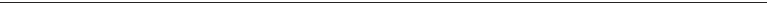
FIGURE1 alkaline cytosolic pH at the root hair tip compared to the base reflects measurements by Bai et al. (2014). (C) Graphical illustration of proton fluxes and oscillatory pH changes at the tip during root hair growth. Light purple arrows indicate net proton fluxes. The pH values are based on the analysis of Monshausen et al. (2007). (D) Growth rate, intracellular Ca 2 + , extracellular pH, and ROS oscillations on a time scale. The figure is adapted from Cárdenas (2009). Time values are from Monshausen et al. (2007) and Monshausen et al. (2008). The dashed curve represents the expected cytosolic pH oscillations. (E) Graphical illustration of how the cell wall pH could influence cell wall cross-linking. The figure is adapted from Schoenaers et al. (2017). (F) Overview of how cytoplasmic pH changes might influence actin polymerization and depolymerization based on the hypothesis from Lovy-Wheeler et al. (2006).